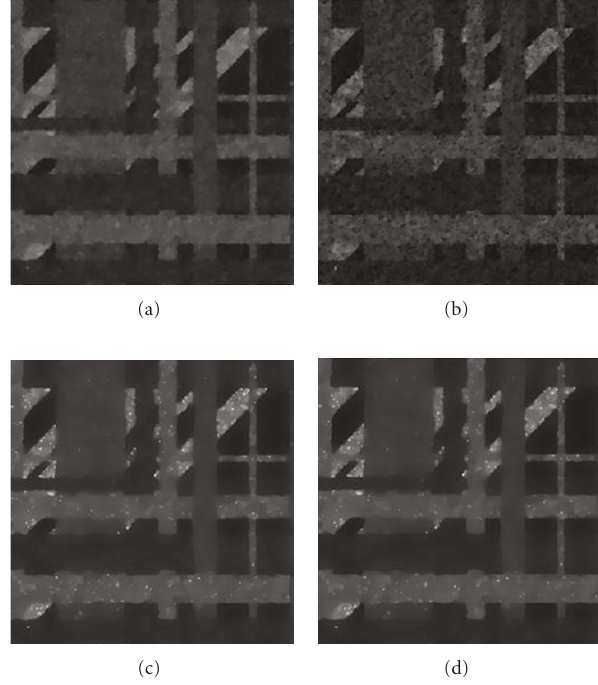
Figure 4: The restored “Lena” images for denoising Figure 2(a): (a) by the proposed method ( α 1 = 0 . 9 × 2 32 , α 2 = 1 . 5 × 2 32 , and ζ = 5 × 10 − 3 ); (b) by the “HMW” method ( α 1 = 0 . 01, α 2 = 0 . 004); (c) by the “AA” method; (d) by the “RLO” method.